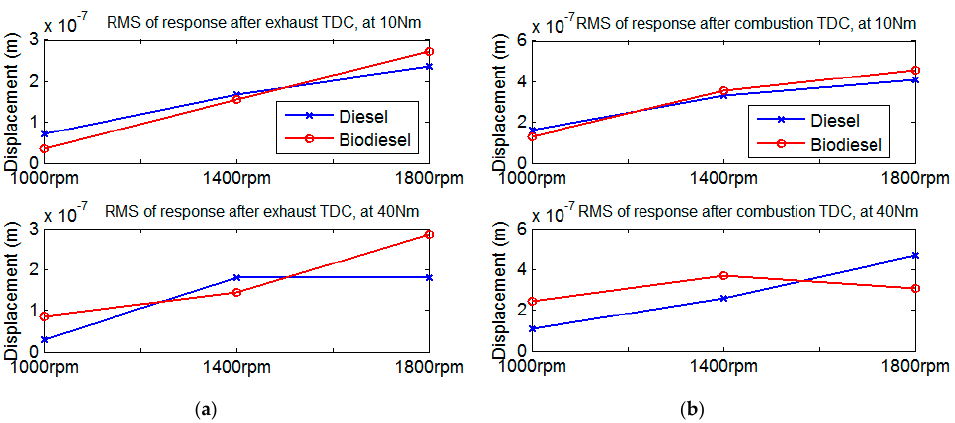
Figure 16. The variation trends of combustion piston slap-induced events; ( a ) Root mean square (RMS) results of predicted displacement response after exhaust top dead center (TDC); ( b ) RMS results of predicted displacement response after combustion TDC.